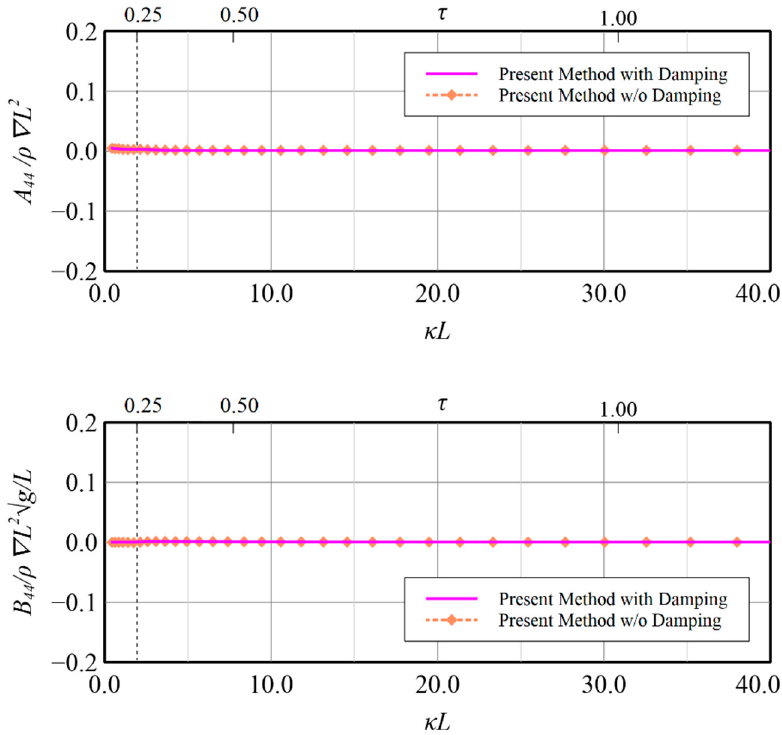
Figure 21. Roll-induced-roll added mass and damping coefficient at F r = 0.18.